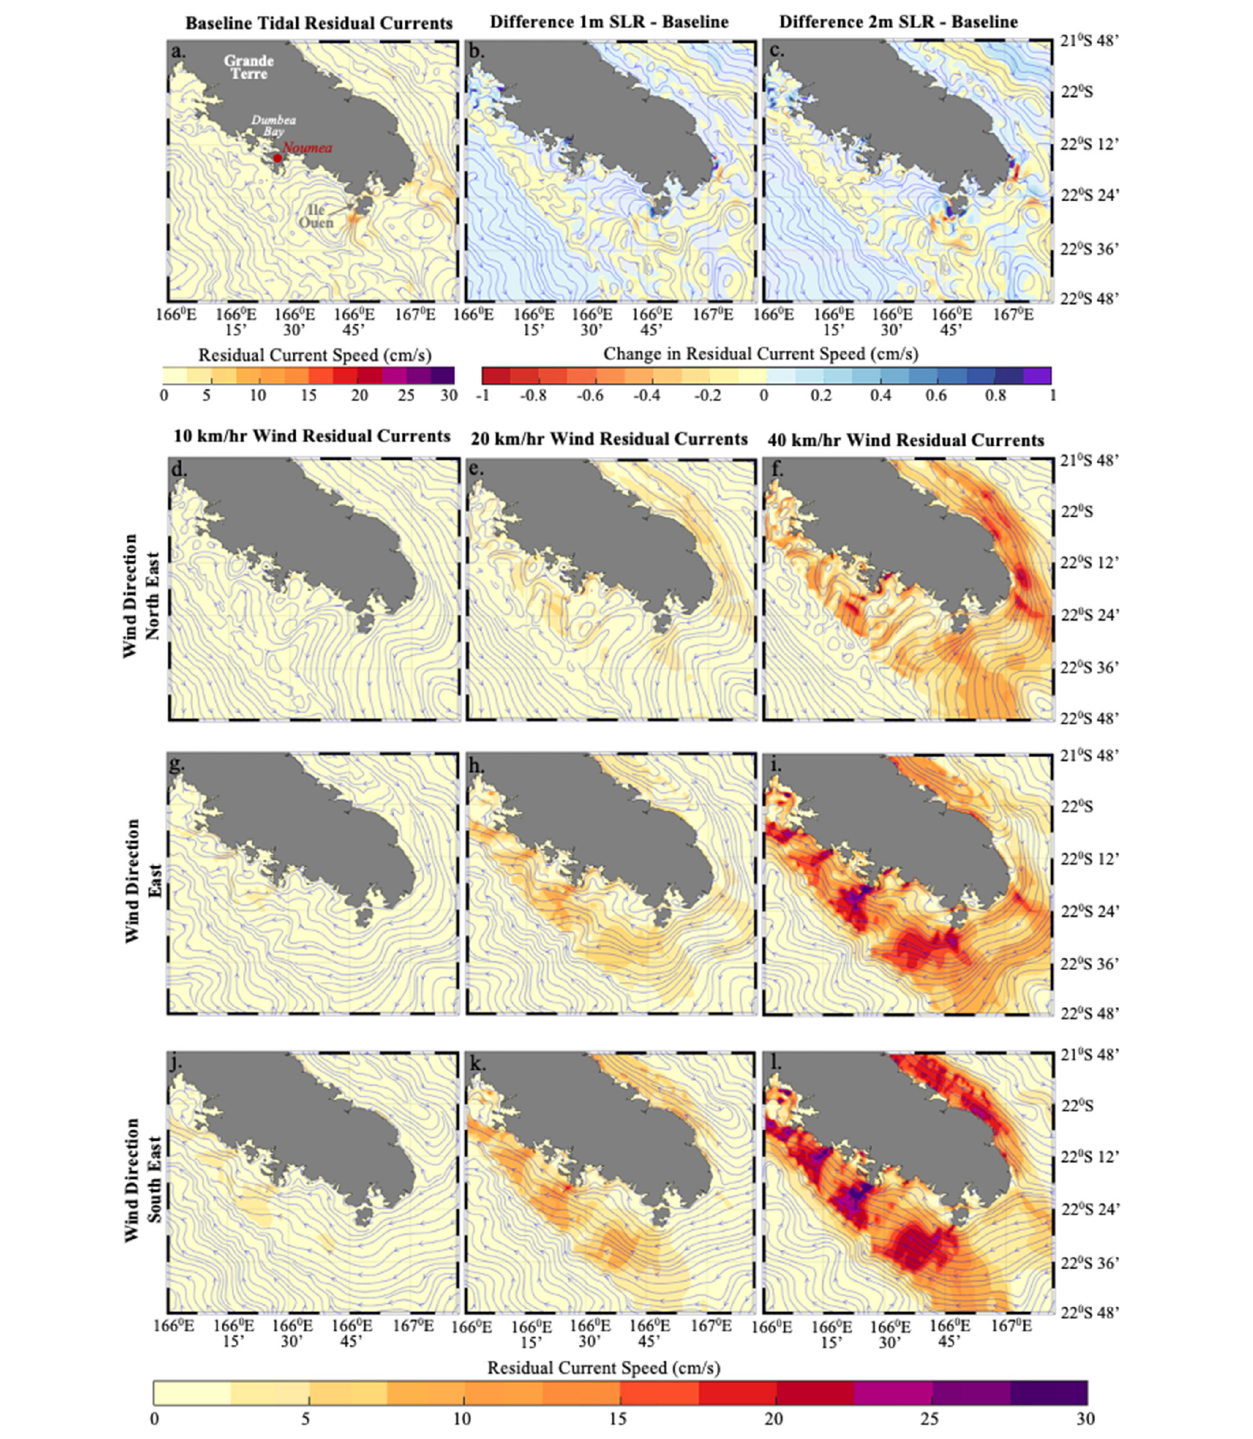
FIGURE 8 | Tidal residual current speeds (cm/s), with current patterns indicated by streamlines for southern Grande Terre, New Caledonia (a) . Change in residual current speeds (cm/s) and patterns under 1 m SLR (b) and 2 m SLR (c) . Wind residual current speeds (cm/s) and patterns under 10 km/h (d) , 20 km/h (e) , and 40 km/h (f) northeast winds. Wind residual current speeds (cm/s) and patterns under 10 km/h (g) , 20 km/h (h) , and 40 km/h (i) east winds. Wind residual current speeds (cm/s) and patterns under 10 km/h (j) , 20 km/h (k) , and 40 km/h (l) southeast winds. Latitudes are displayed to the right of panels (c,f,i,l) . Longitude for all panels are displayed below panels (a–c,j–l)